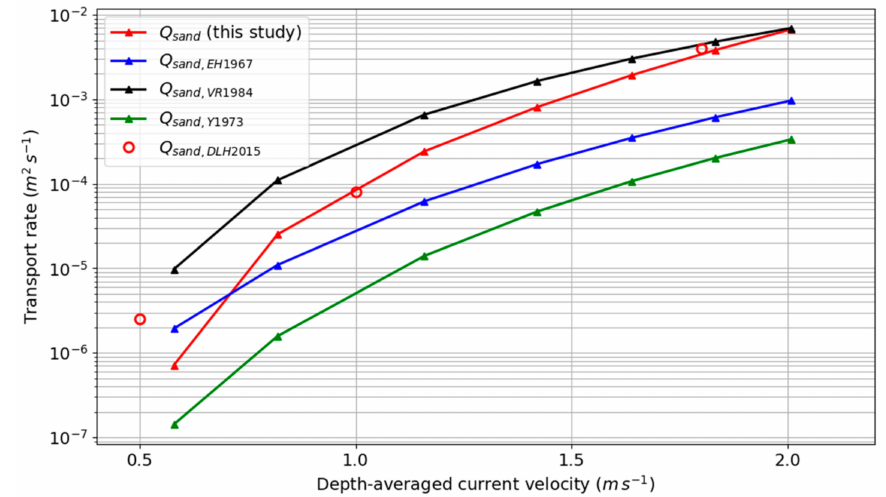
Figure 3. Sand (200 µ m diameter) transport rates computed with a 1DV model using the pure sand erosion law, and obtained for different flow intensities (solid red curve). For identical flow intensities and sand diameter, sand transport rates deduced from empirical formulations of Van Rijn [50] (black curve), Engelund and Hansen [51] (blue curve), and Yang [52] (green curve) are illustrated. Empty red circles refer to the modelling results of Dufois and Le Hir [53] representing transport rates of a 200 µ m sand under different flow intensities from an advection/diffusion